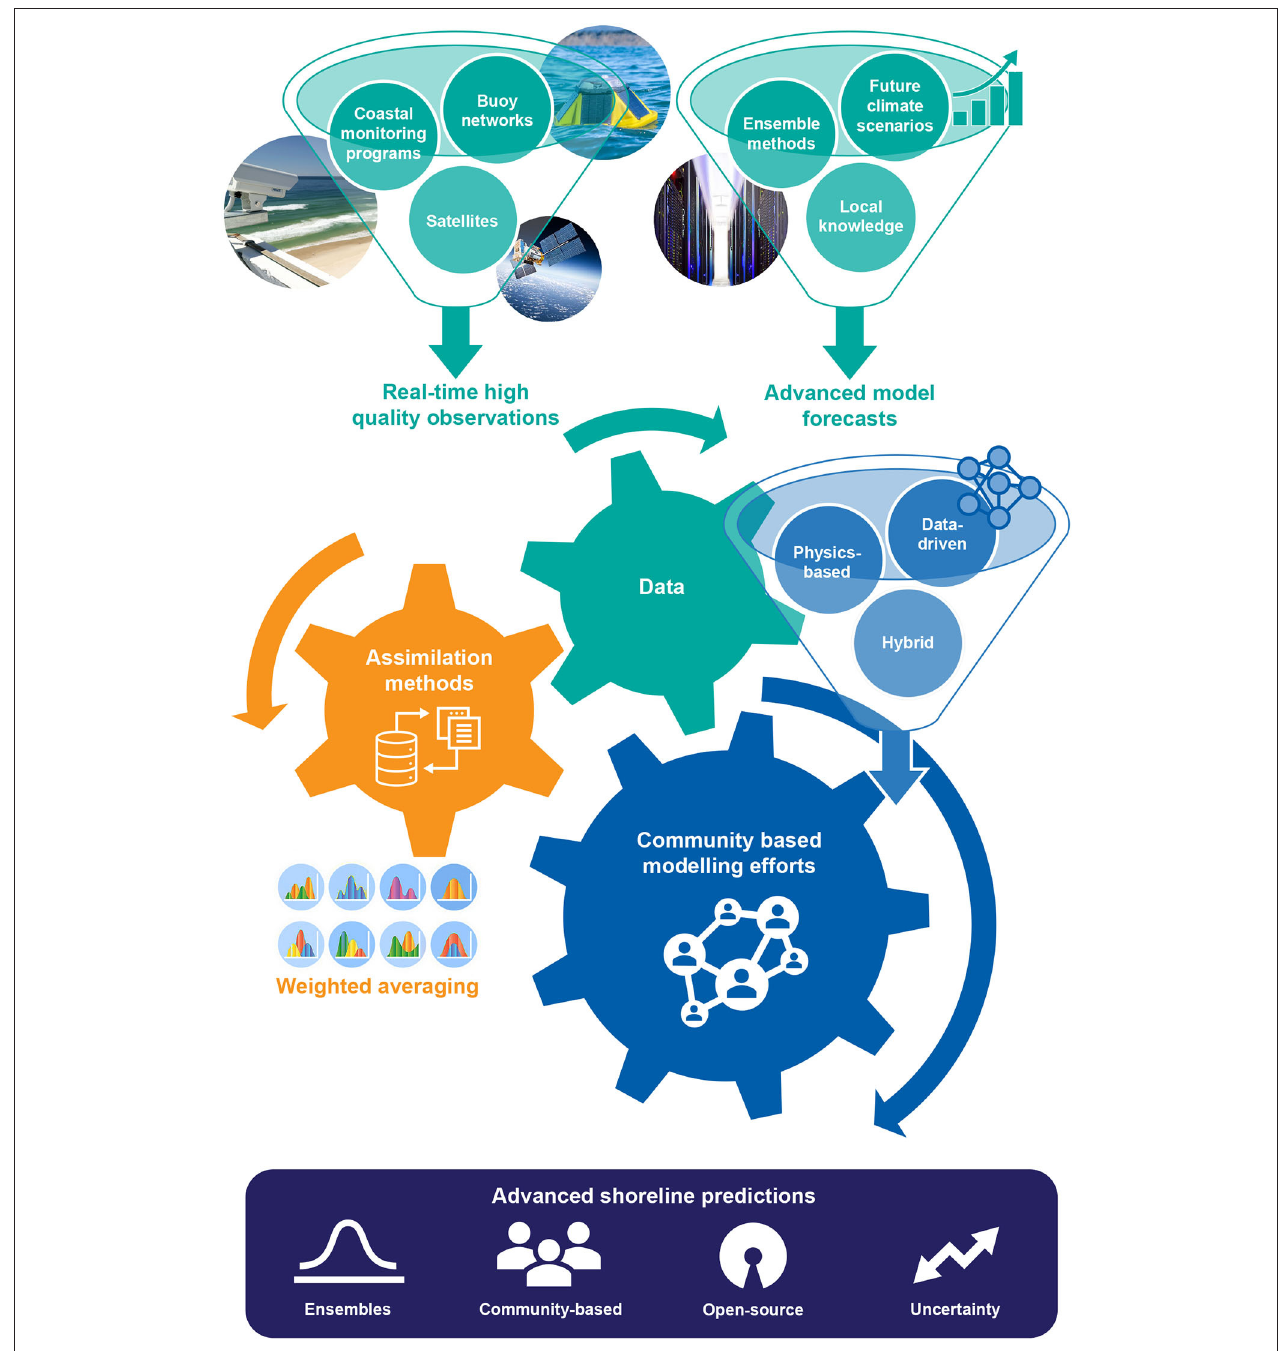
FIGURE 2 | A framework for future shoreline change